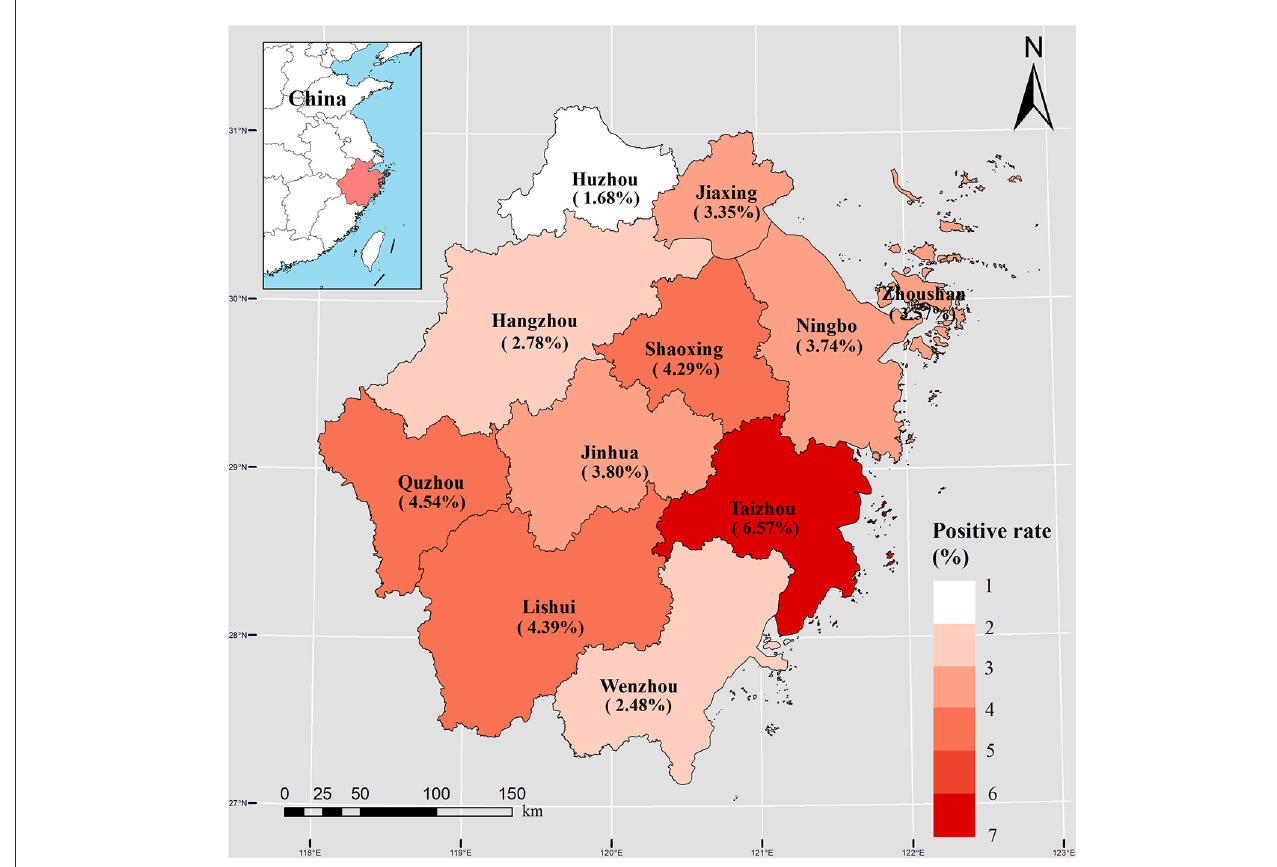
FIGURE2 Spatial distribution of 11,269 Salmonella cases during 2012–2021 in 11 cities of Zhejiang Province.